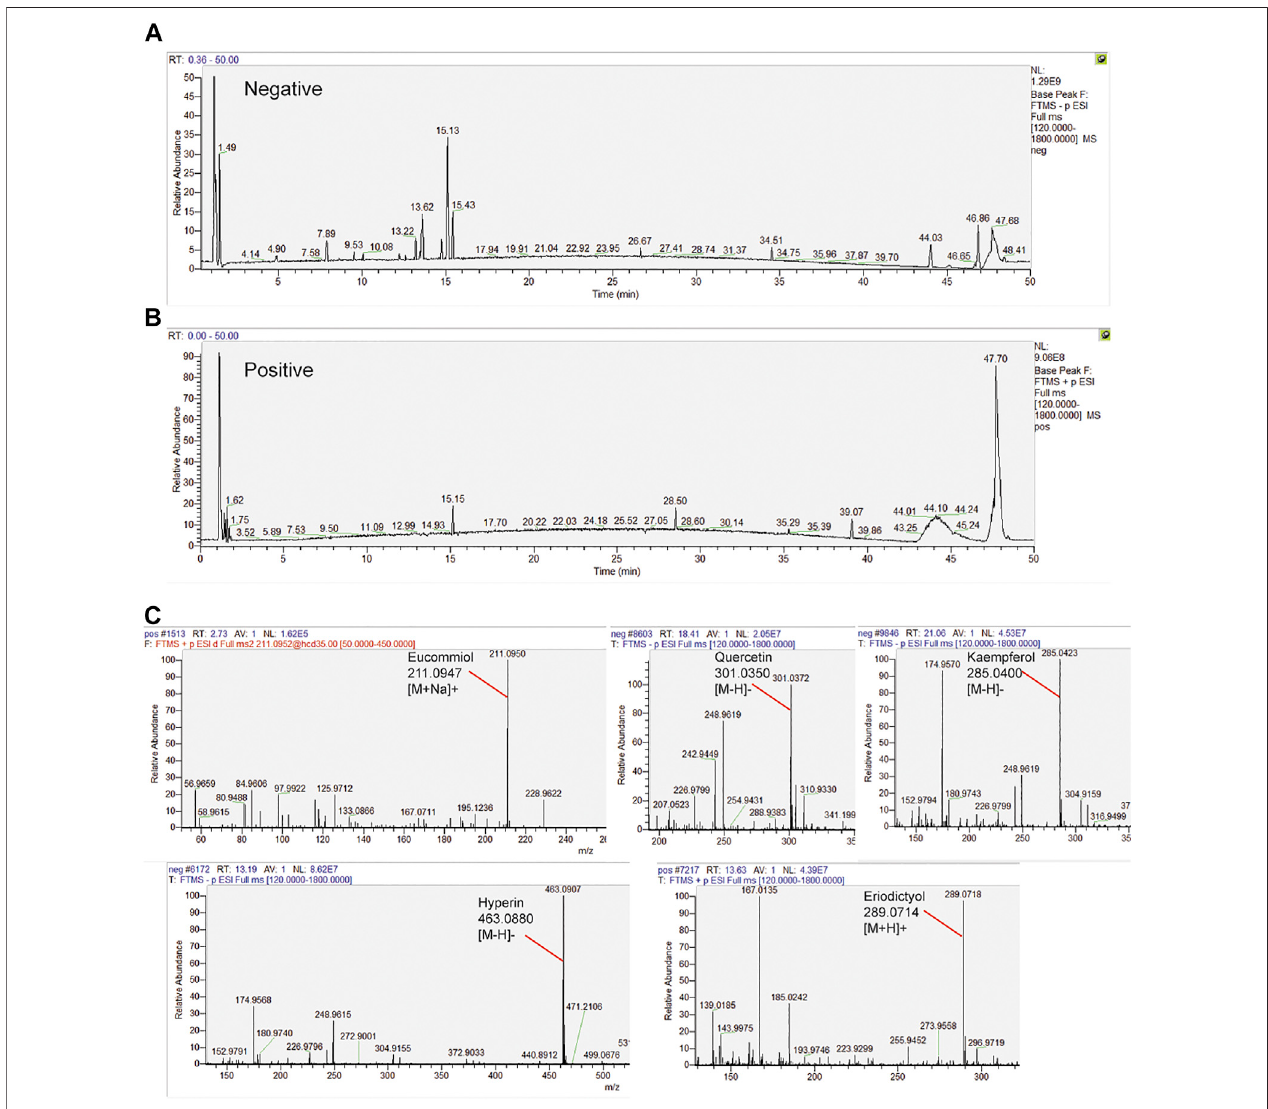
FIGURE 6 | HPLC analysis identi fi ed constituents in the E.C.D. extracts. (A,B) Total ion chromatogram analyzed in positive and negative ion modes for E.C.D. extracts. (C) E.C.D. extracts constituent analysis: Eucommiol, Quercetin, Kaempferol, Hyperin, and Eriodictyol.